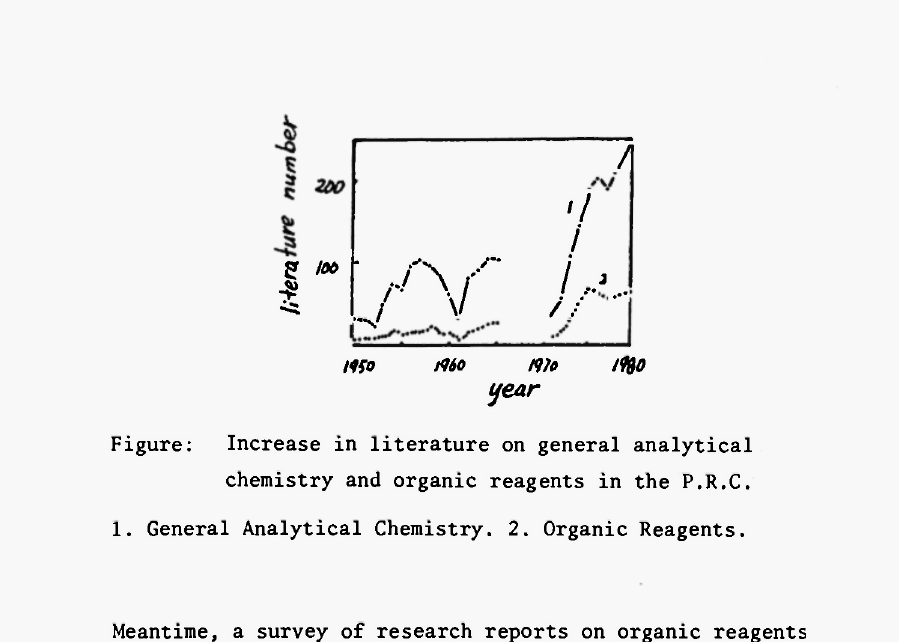
Figure: Increase in literature on general analytical chemistry and organic reagents in the